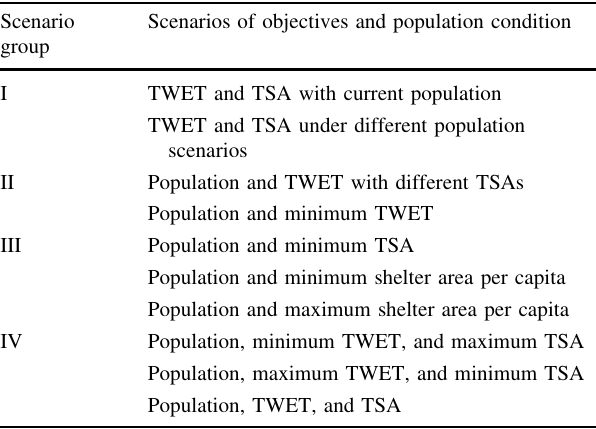
Table 1 Objectives and population condition scenarios used in this study Scenario